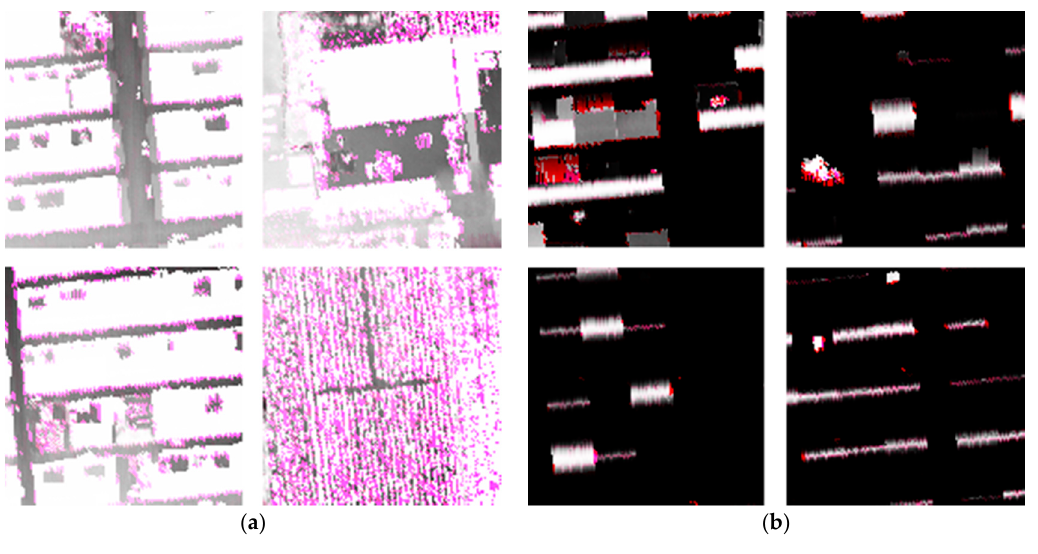
Figure 5. Training samples of the feature images corresponding to: ( a ) ground points; and ( b ) non-ground points.